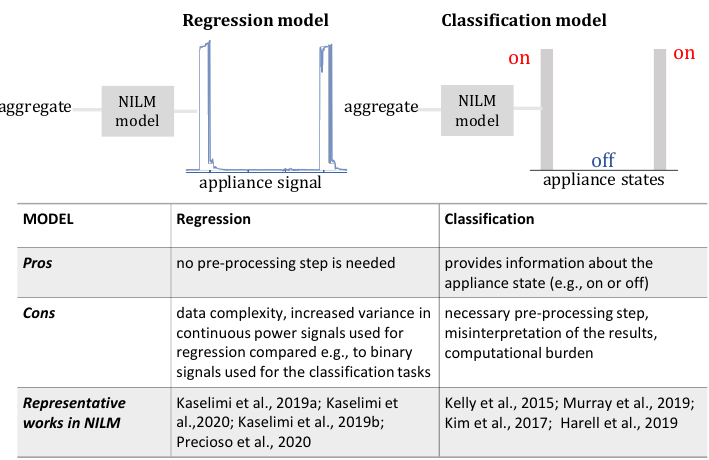
Figure 3. NILM as a regression or classification problem